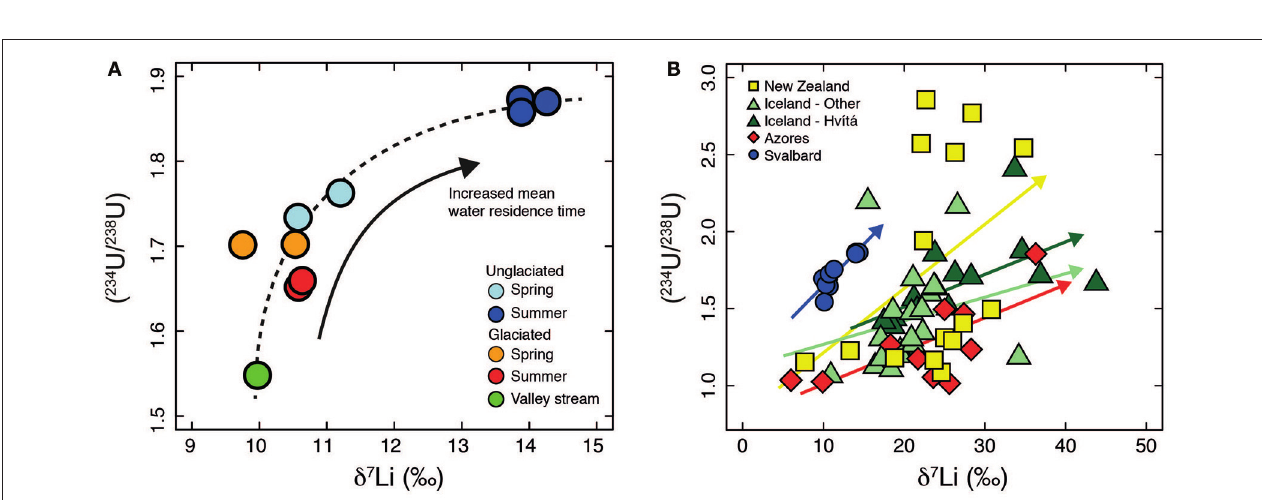
FIGURE 8 | (A) Plot of ( 234 U/ 238 U) vs. δ 7 Li for Svalbard (this study). The dashed line indicates the overall trend in the data. The positive trend would be consistent with a residence time control. (B) Plot of ( 234 U/ 238 U) vs. δ 7 Li. Data from New Zealand (Pogge von Strandmann and Henderson, 2015), Iceland (Pogge von Strandmann et al., 2006; Vigier et al., 2006, 2009), Azores (Pogge von Strandmann et al., 2010) and Svalbard (this study). There is no global relationship between ( 234 U/ 238 U) and δ 7 Li. Relationships are specific to each catchment and are dependent on local environmental conditions and are indicated by the colored arrows.